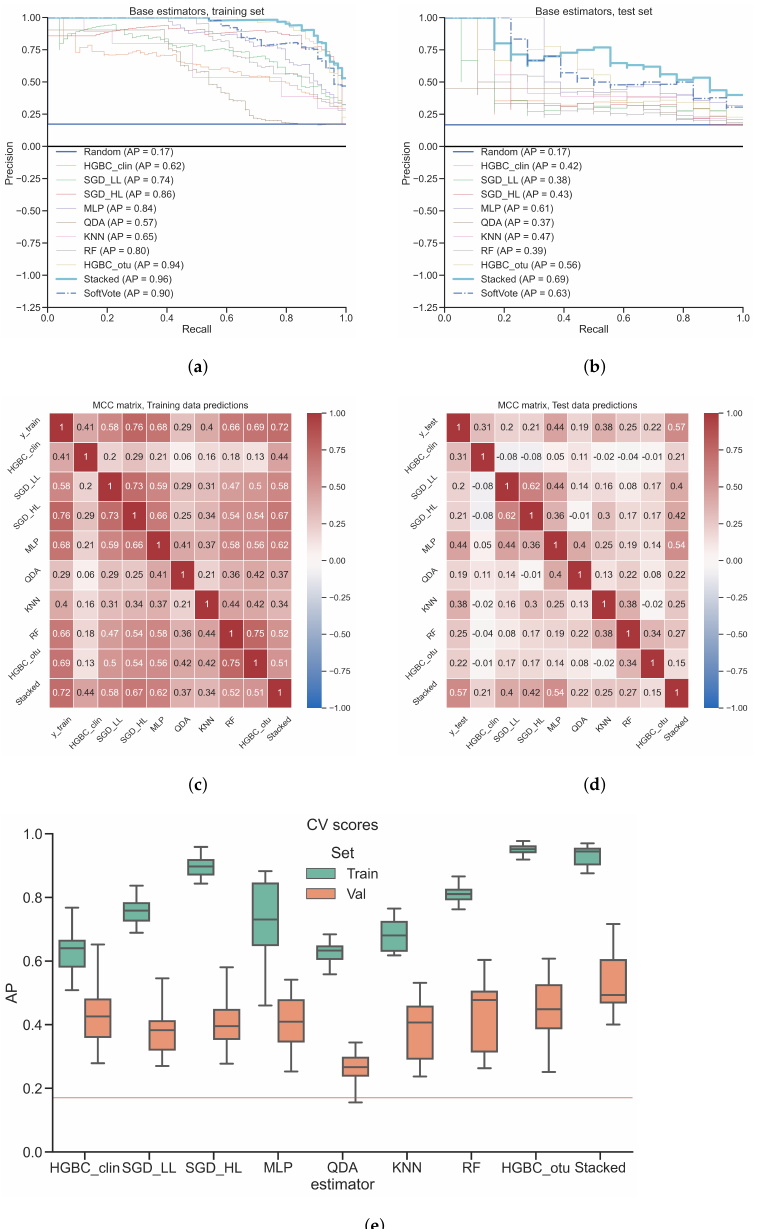
Figure 2. Model performance comparison between base learners and stacked model, inflamma- tory bowel disease dataset. ( a ) Precision-Recall (PR) curves and corresponding Average Precision